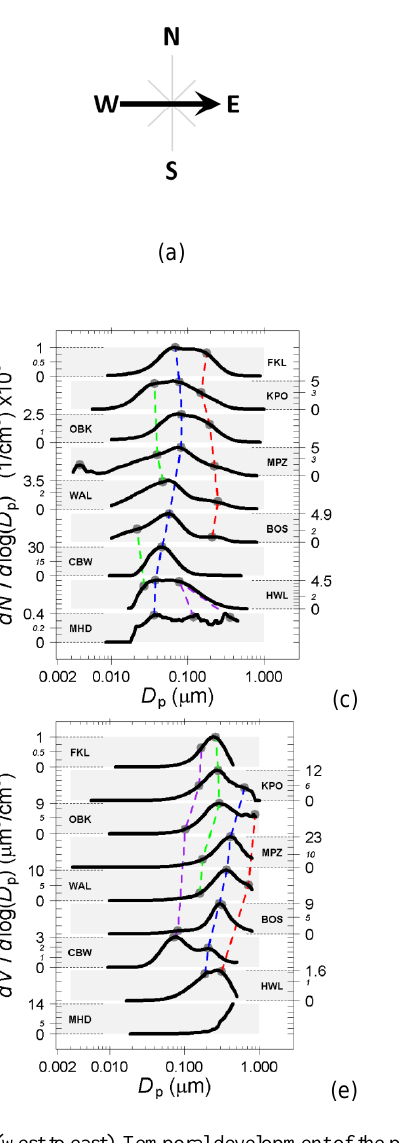
Fig. 8. Case study 1 (west to east). Temporal development of the particle size spectra plotted along the 5-day back-trajectory shown in plotted green/red from midnight to midnight on the particle number (PN) emission map shown in (b) , starting southwest of MHD on 18 December 2008 and arriving at FKL on 24 December 2008 at 00:00. The stacked number and volume spectra (c, e) show the size distributions measured at the sites as the air mass passes. The modal diameter of the fitted distributions are indicated by circles and the progress plotted by the coloured lines which are coded to indicate the fraction of total number for each site plotted against distance in (d, f) . The dotted lines in (c) and (e) are primarily to guide the eye, rather than being proposed as a firm causal